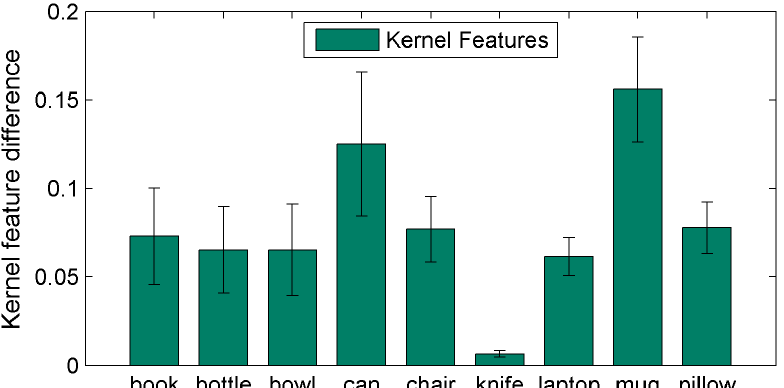
Figure 10. Comparison of kernel features when using 3 × 3 kernel to identify similarities between objects. Zero indicates that kernel features are identical to those of ground